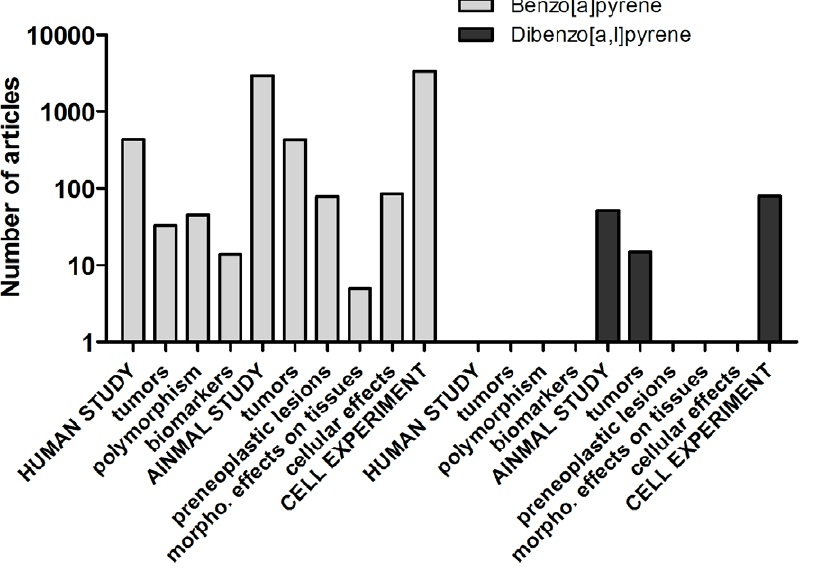
Figure 8. Distribution of classified abstracts over the Scientific Evidence for Carcinogenic Activity taxonomy for two chemicals, benzo[a]pyrene and dibenzo[al]pyrene.